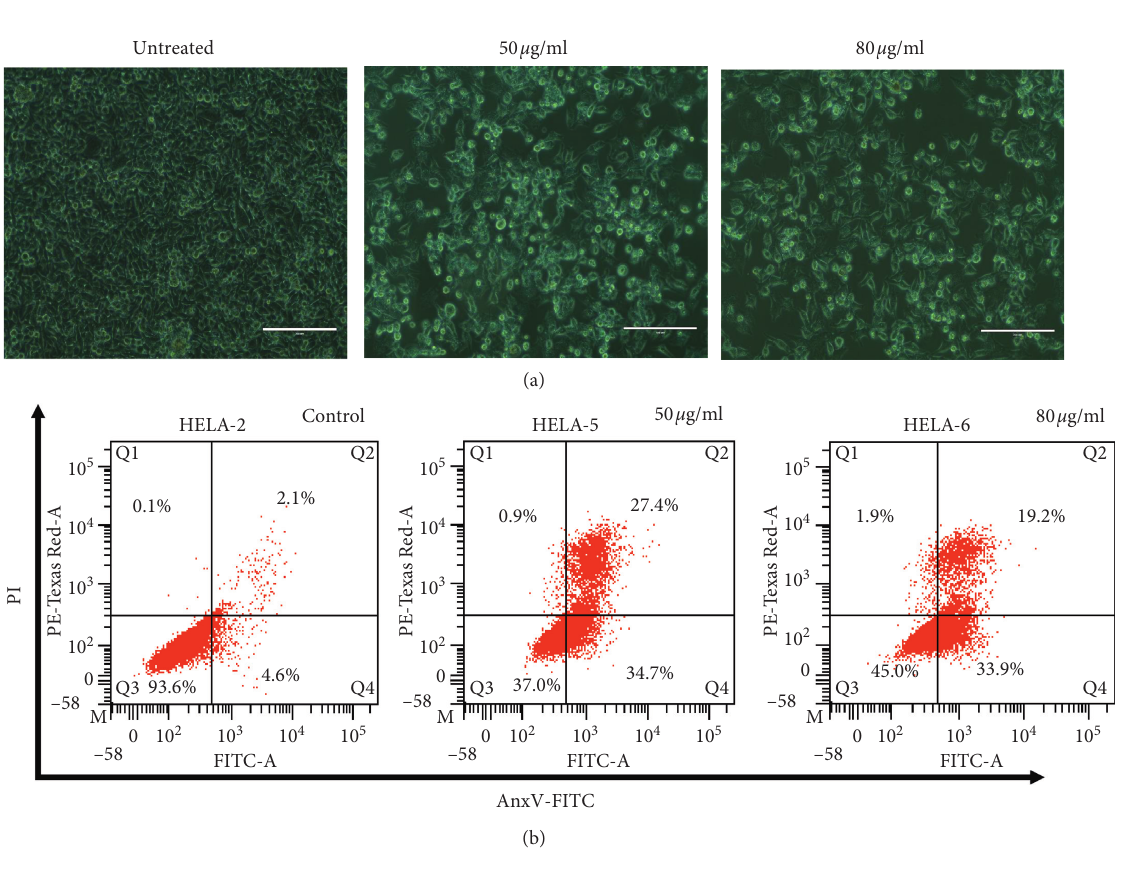
Figure 3: Representative photomicrographs of the cellular morphological signatures after treatments with N97. Apoptosis was detected by FCM Annexin V/PI staining (a). Representative Annexin V FITC-A vs propidium iodide-A contour plots from three concentrations of N97. HeLa cells were treated with the N97 extract for 48 h (b).